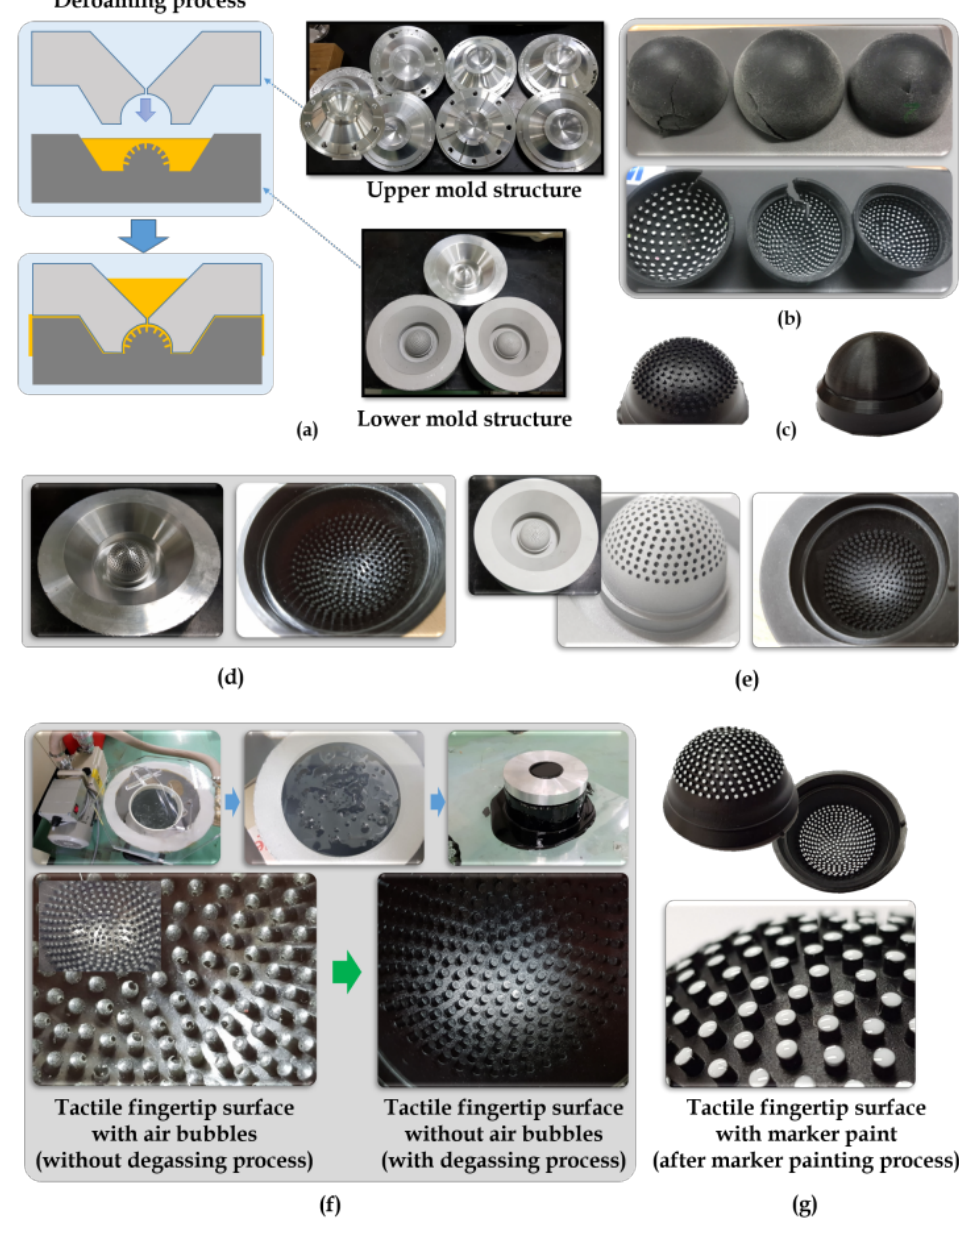
Figure 4. Making of tactile fingertips: ( a ) Defoaming process with upper mold and lower mold structures. ( b ) Fingertips produced from 3D printing process. ( c ) Fingertips produced from defoam- ing injection mold process. ( d ) Mold injection causes surface light reflection. ( e ) Sanding the mold surface reduced the light reflection. ( f ) Vacuum degassing process. ( g ) Marker painting